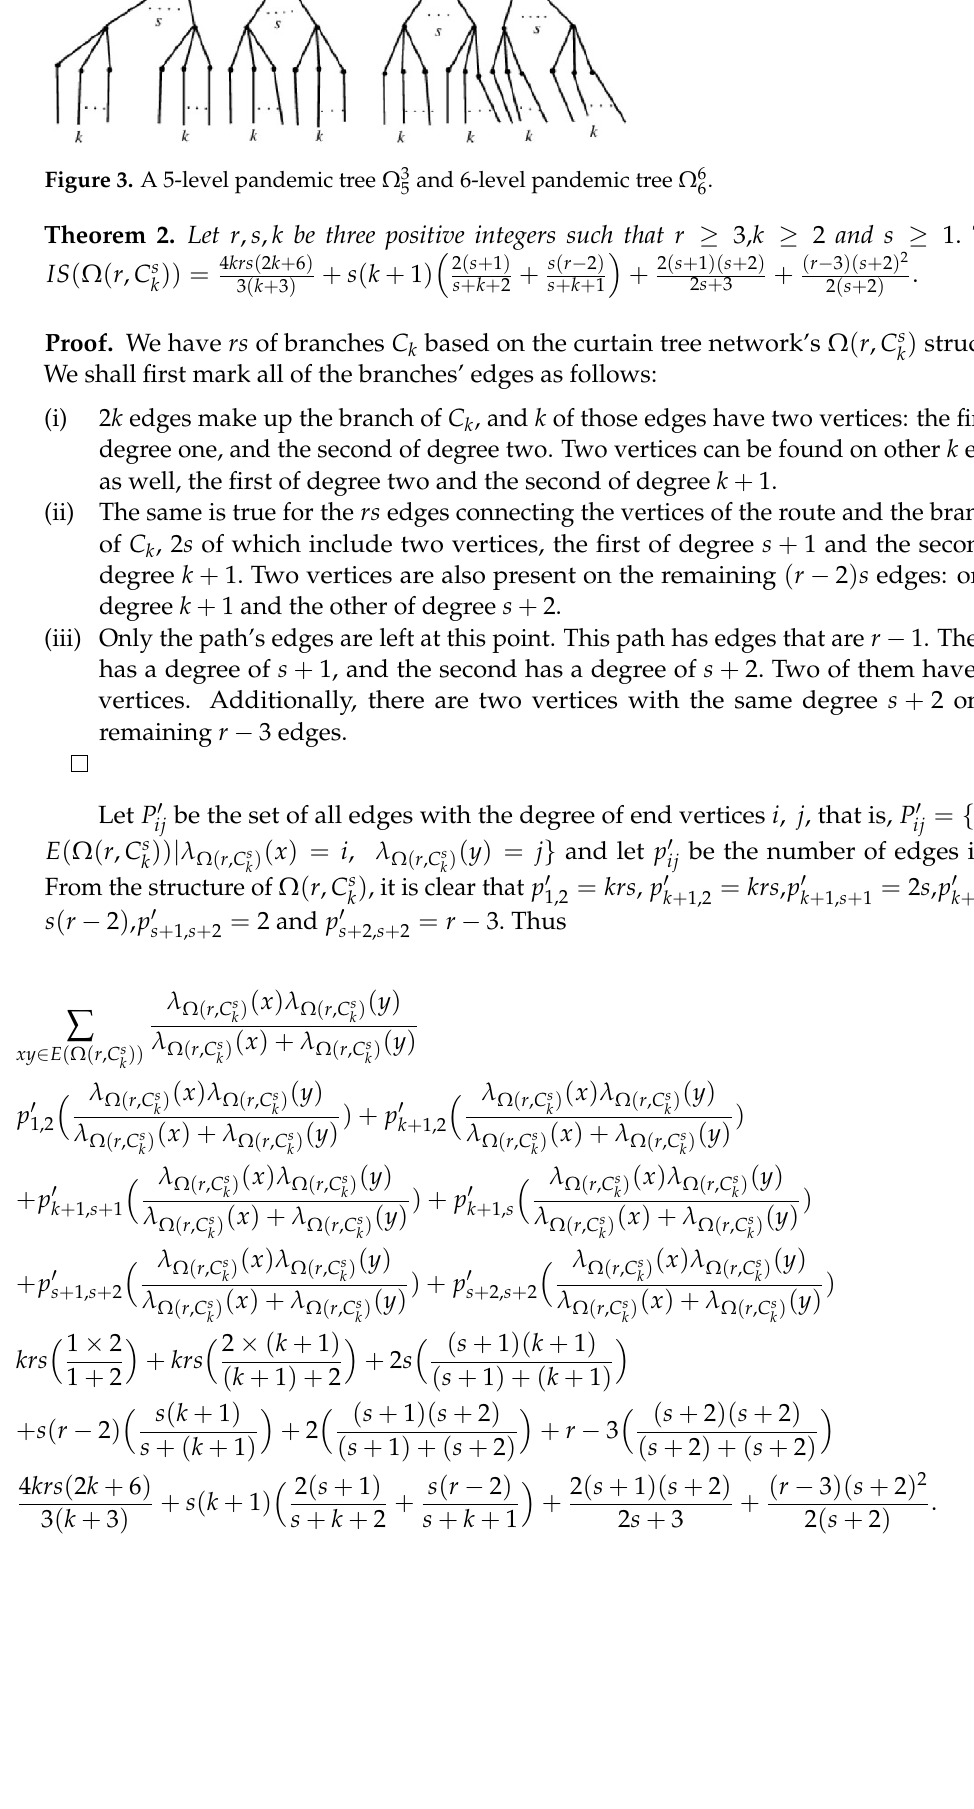
Figure 3. A 5-level pandemic tree Ω 3